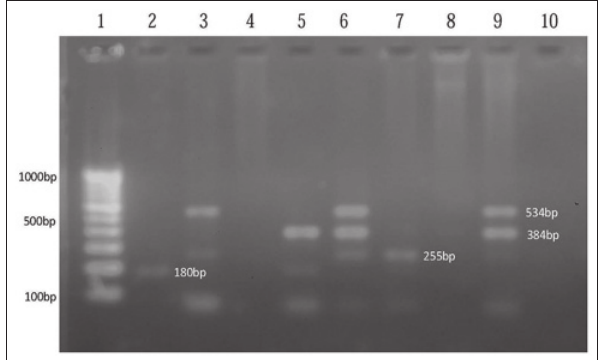
Figure 1: Agarose gel showing PCR amplified product for VTEC gens isolates from faecal sample of Deer. Lane 1:100bp DNA Ladder, Lane 2: Stx Lane 5: